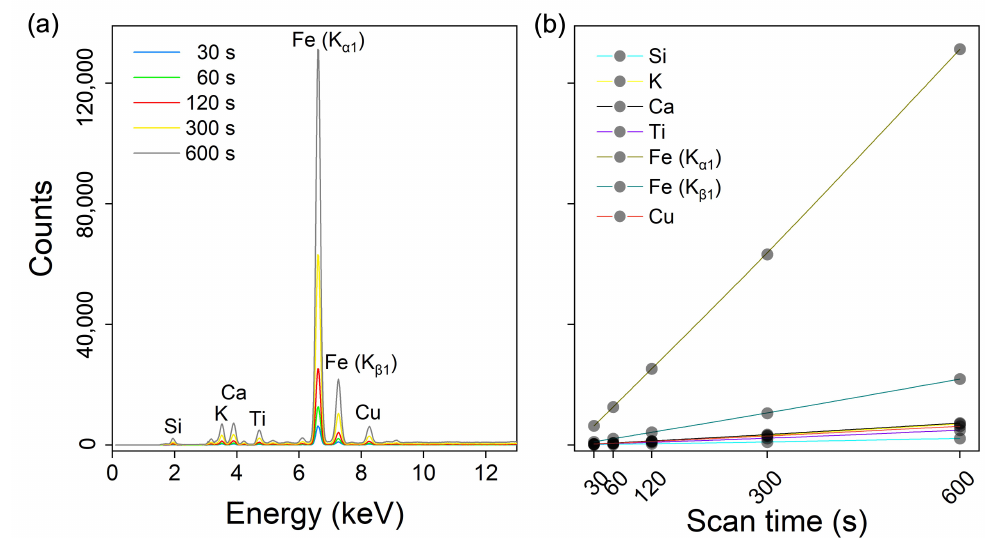
Figure 1. Representative XRF soil spectrum annotated with some dominant peaks and their corre- sponding energies ( a ) and the changes in the character peaks’ intensity under the excitation times changes ( b